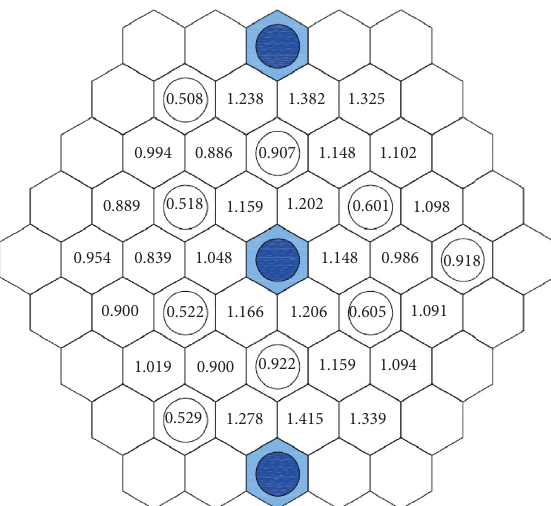
Figure 6: Radial relative power distribution of the MPRR core at the